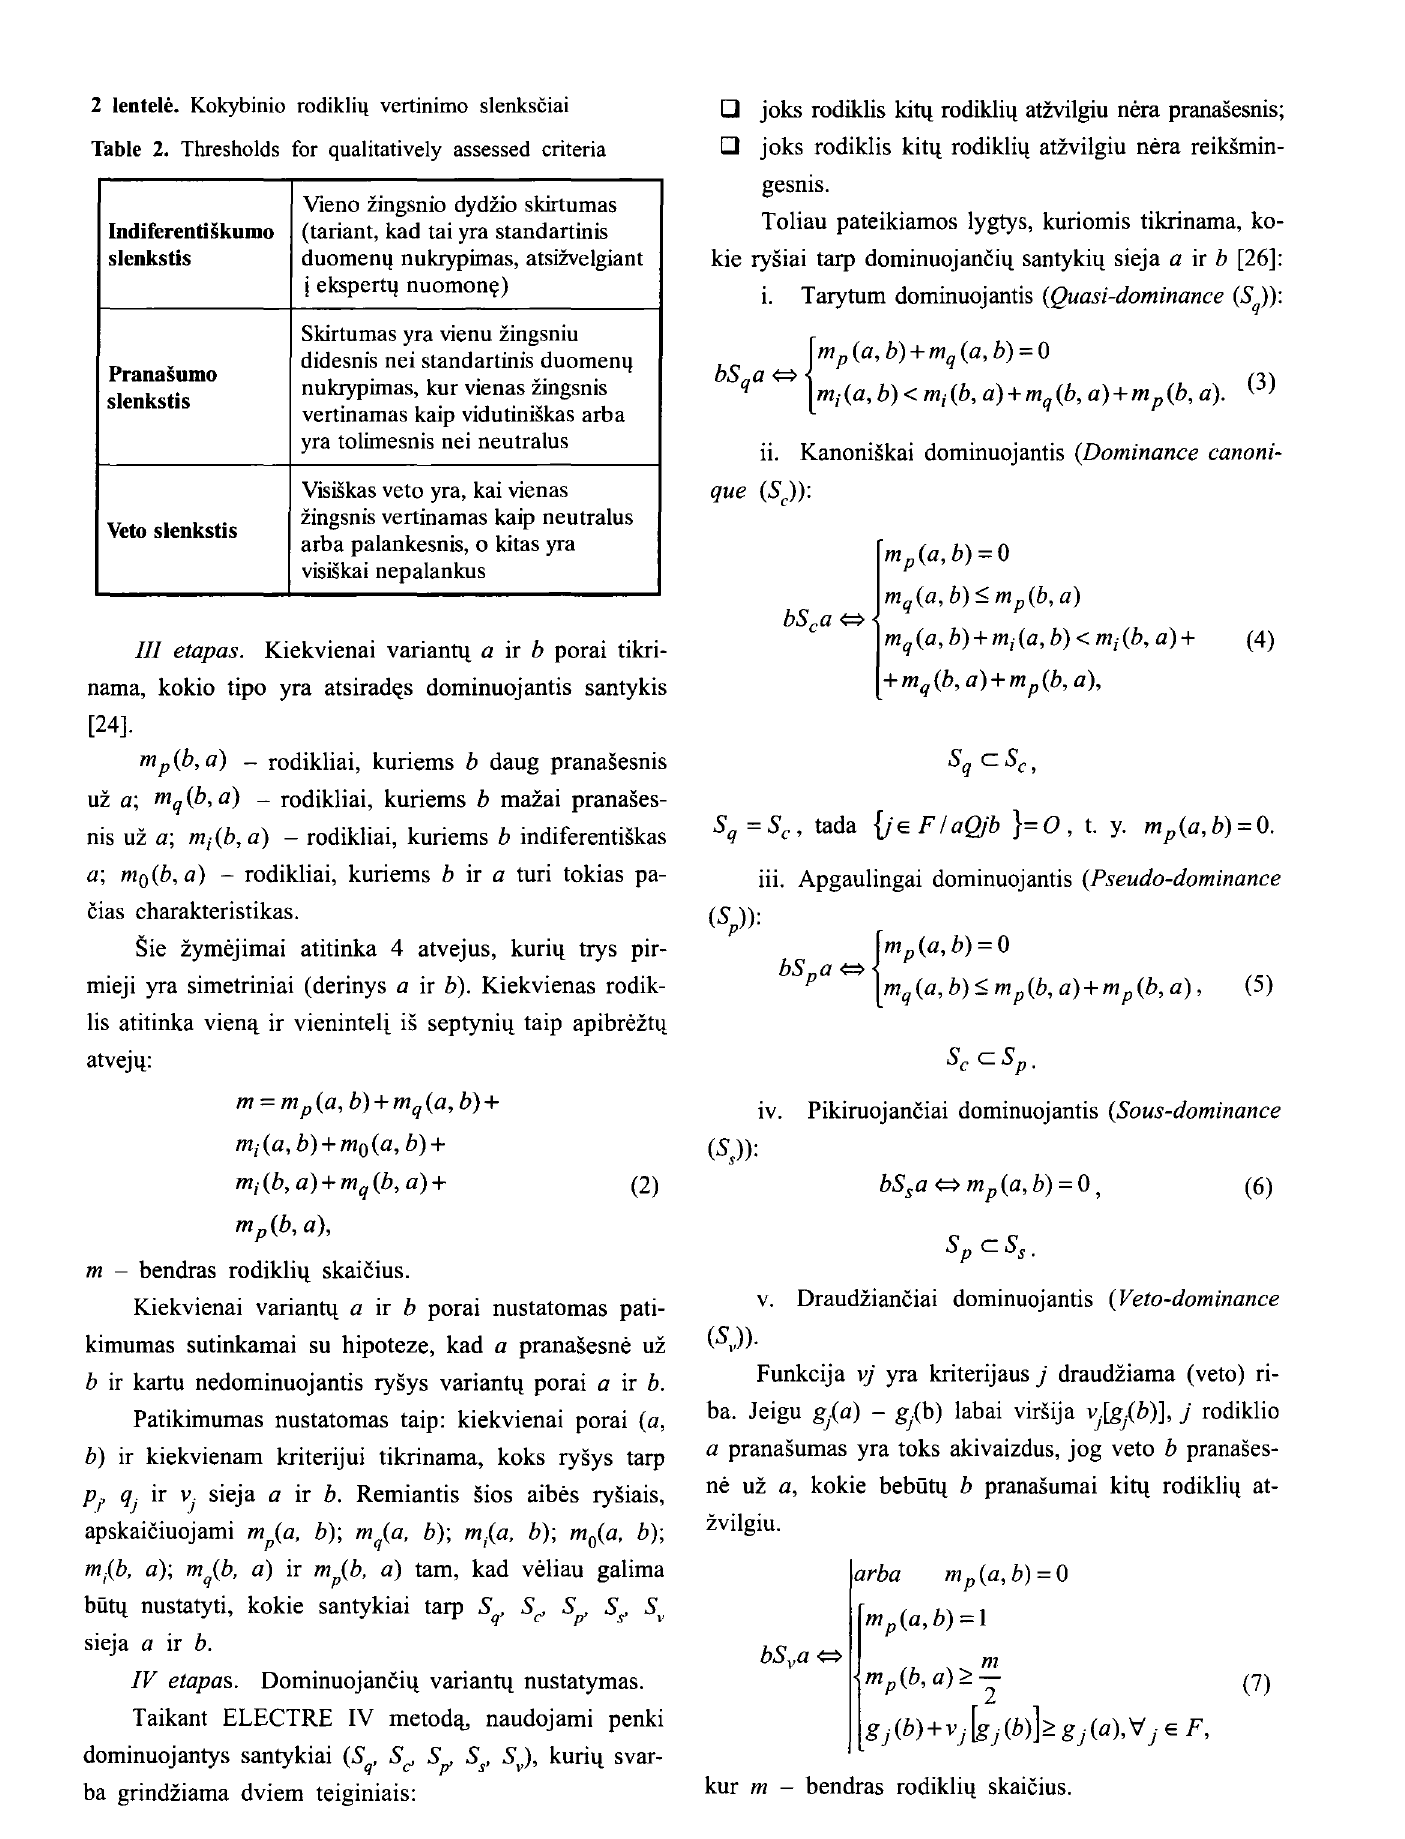
D joks rodiklis kitq rodikliq at:Zvilgiu nera reiksmin